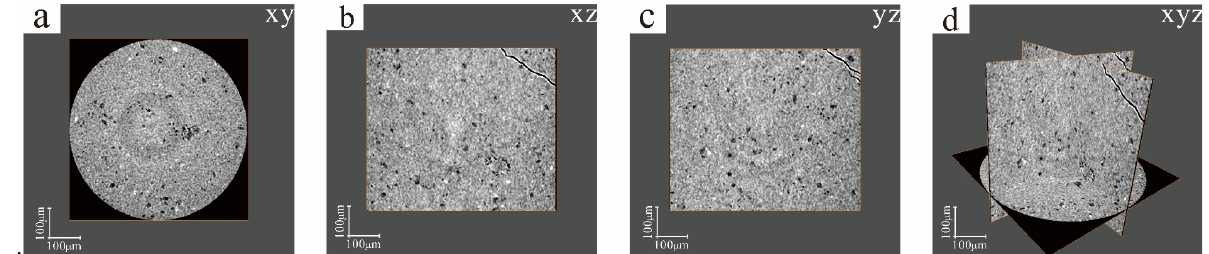
Figure 16. Micro-CT slice image of sample HZ-14 in the Huize lead–zinc deposit. ( a ) Sample xy section Micro-CT scan image; ( b ) Sample xz section Micro-CT scan image; ( c ) Sample yz section Micro-CT scan image; ( d ) Micro-CT scanning mosaic image of sample xyz section